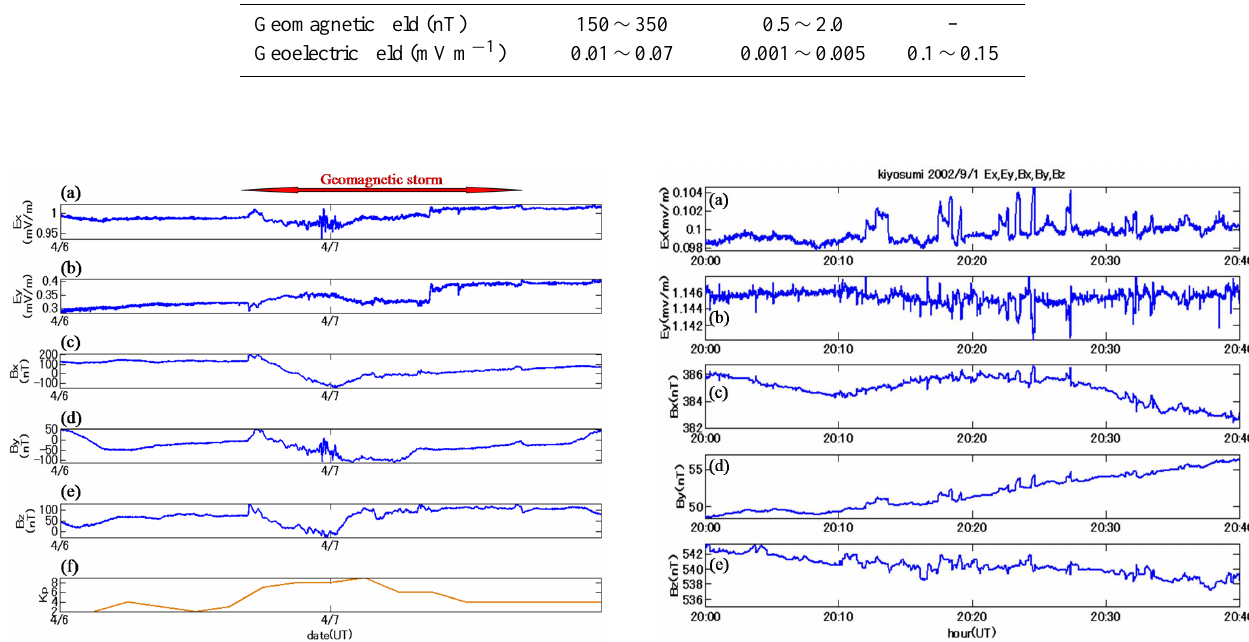
Fig. 1. An example of ULF electromagnetic variation associated with a geomagnetic storm. (a) Ex component (mVm − 1 ), (b) Ey component (mVm − 1 ), (c) Bx component (nT), (d) By component (nT), (e) Bz component (nT), and (f) Kp index.